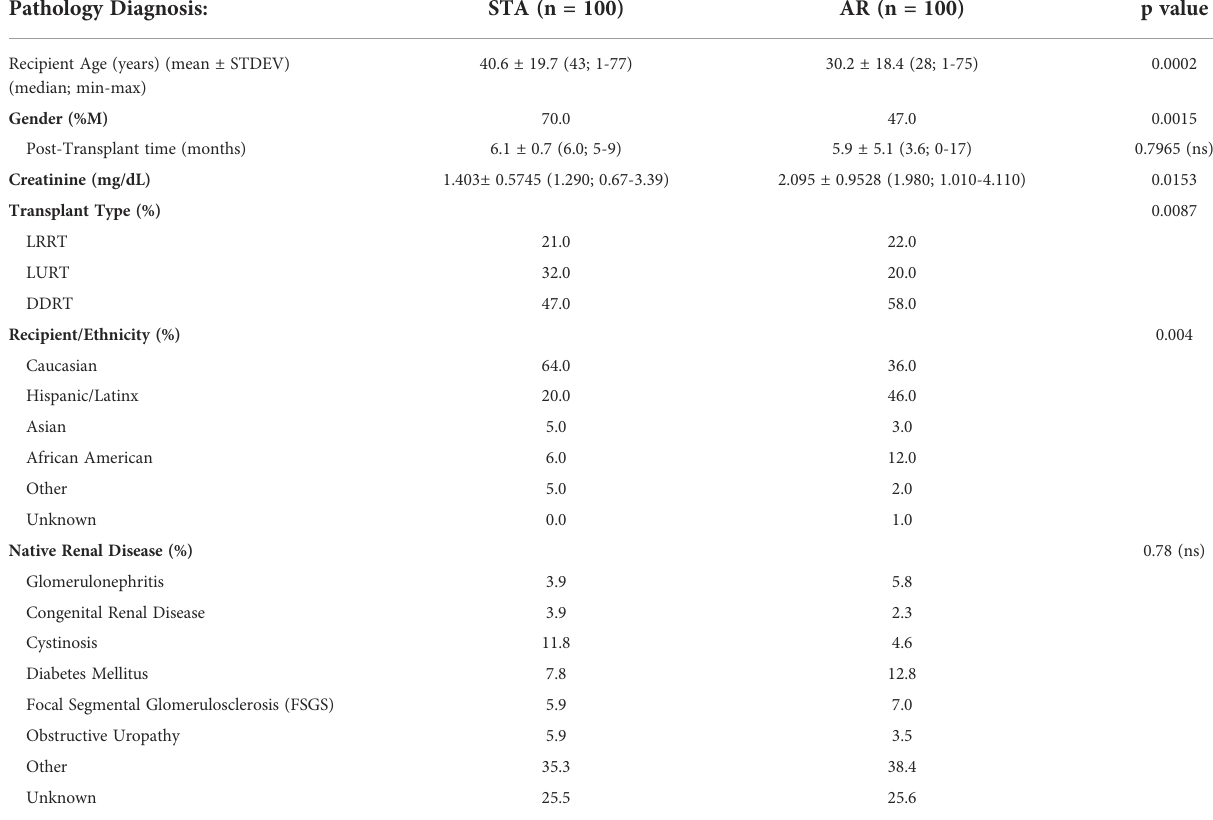
TABLE 1 Demographic and baseline